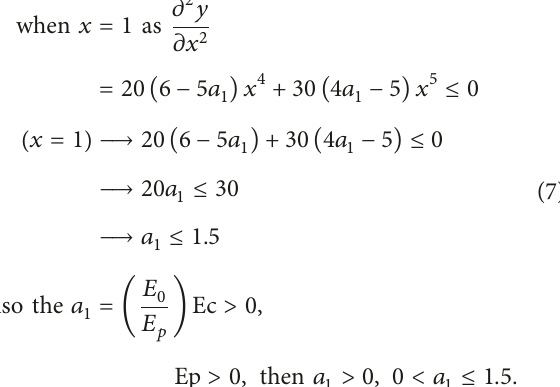
Figure 9: Typical fiber reinforced cement uniaxial stress-strain